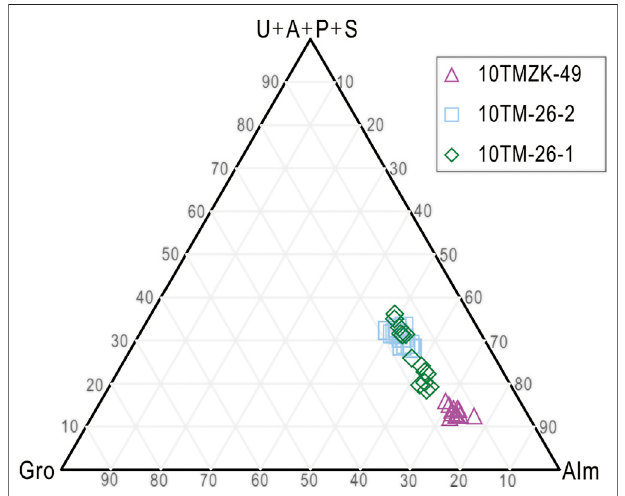
FIGURE 6 | Classi fi cation diagram for the Tiemurt garnets. Abbreviations: Gro (cid:1) grossular, And (cid:1) andradite, Ura (cid:1) uvarovite, Pyr (cid:1) pyrope, Spe (cid:1) spessartine, and Alm (cid:1) almandine.